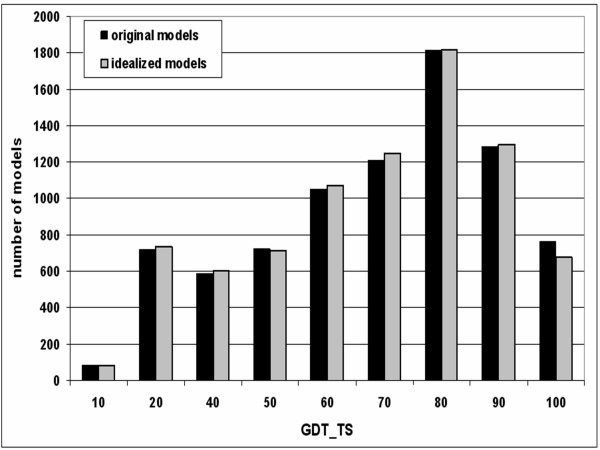
The distribution of GDT_TS scores indicating (dis)similarity between the native structures of CASP targets in the CM and FR(H) categories and the corresponding models: original ones (the CASP5&6 all) and their idealized versions (the CASP5&6+ all).